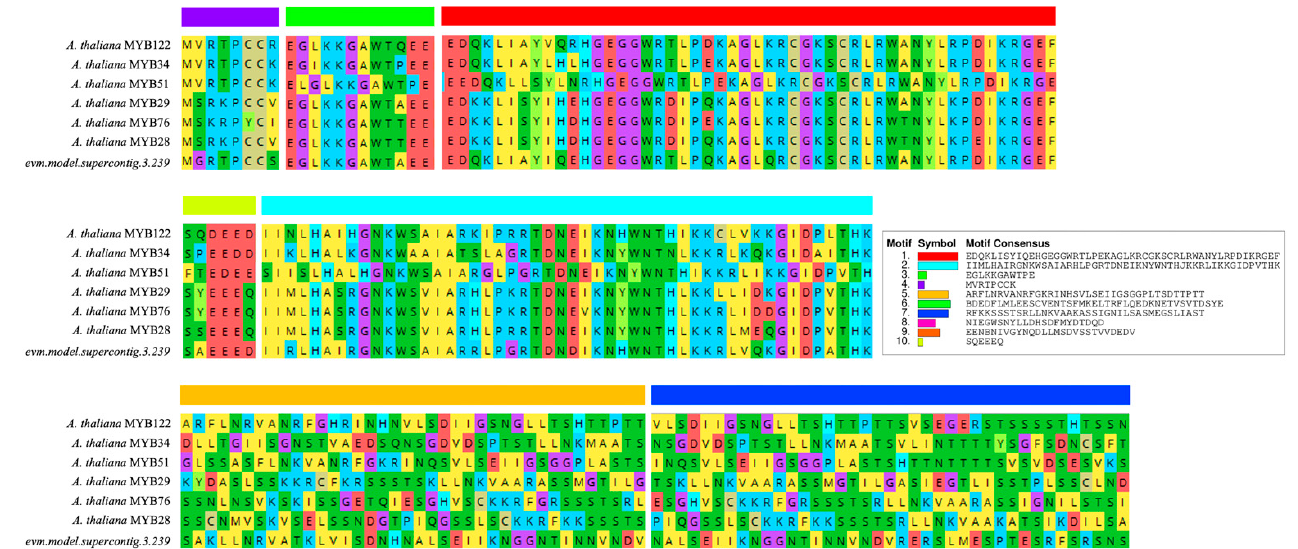
Figure 4. Motif structure of evm.model.supercontig 3.239 compared to A. thaliana MYB genes based on multiple sequence alignment, highlighting the presence of a unique MYB-like family motif (Motif 5) and unique aliphatic GSL motif (Motif 7) in the sequence. evm.model.supercontig 3.239 has been annotated as a probable MYB transcription factor-related gene using Phytozome 13 and SuCComBase databases.